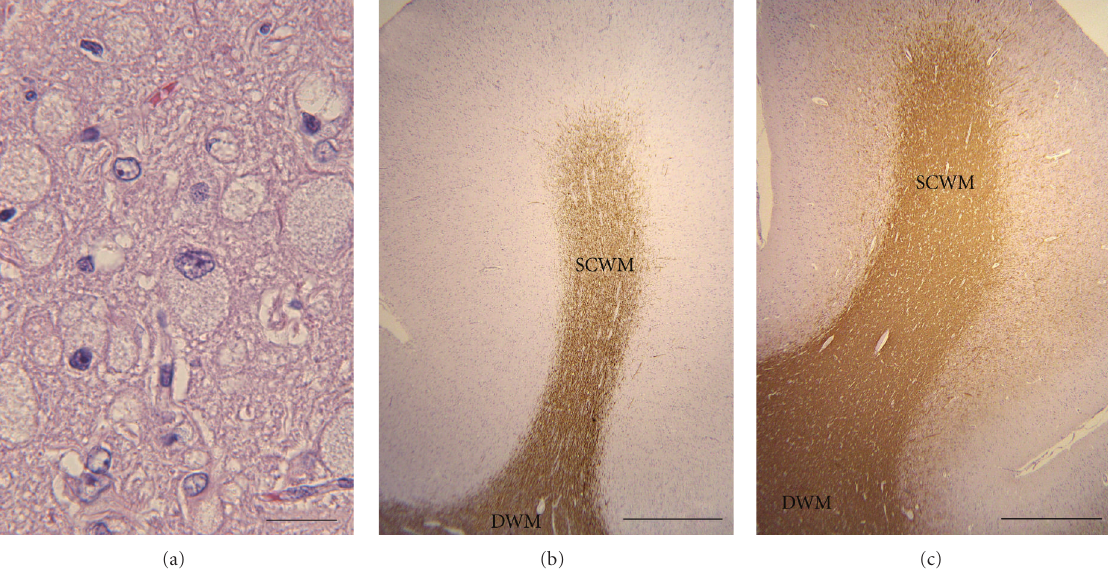
Figure 6: Histological findings in the a ff ected laboratory dog. (a) High magnification of hematoxylin and eosin stain. Markedly swollen neurons filled with the storage materials were found throughout the central nervous system. Bar = 50 μ m. (b) Anti-MBP immunohistochemistry of the cerebrum in an 11-month-old a ff ected dog and (c) a 2-year-old control mixed-breed dog. Poor myelination was particularly detected in the subcortical white matter in the a ff ected dog compared with that in the control dogs. SCWM: subcortical white matter, DWH: deep white matter. Bar =